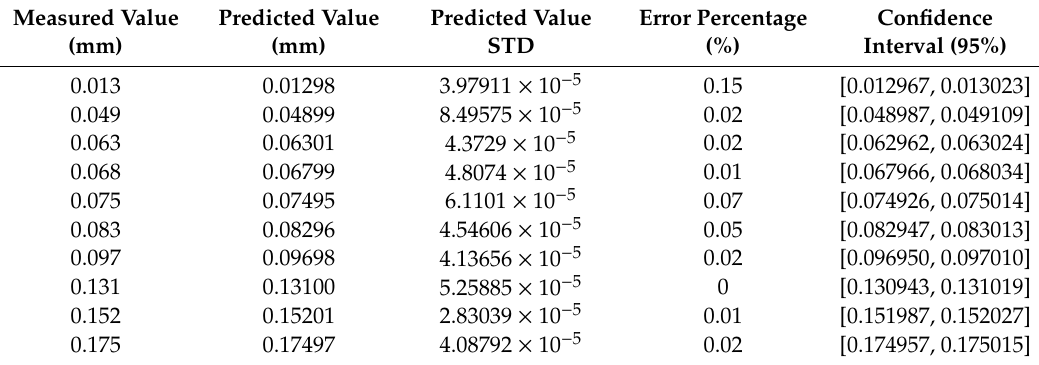
Table 2. Comparison between the measured and the predicted values in C1.